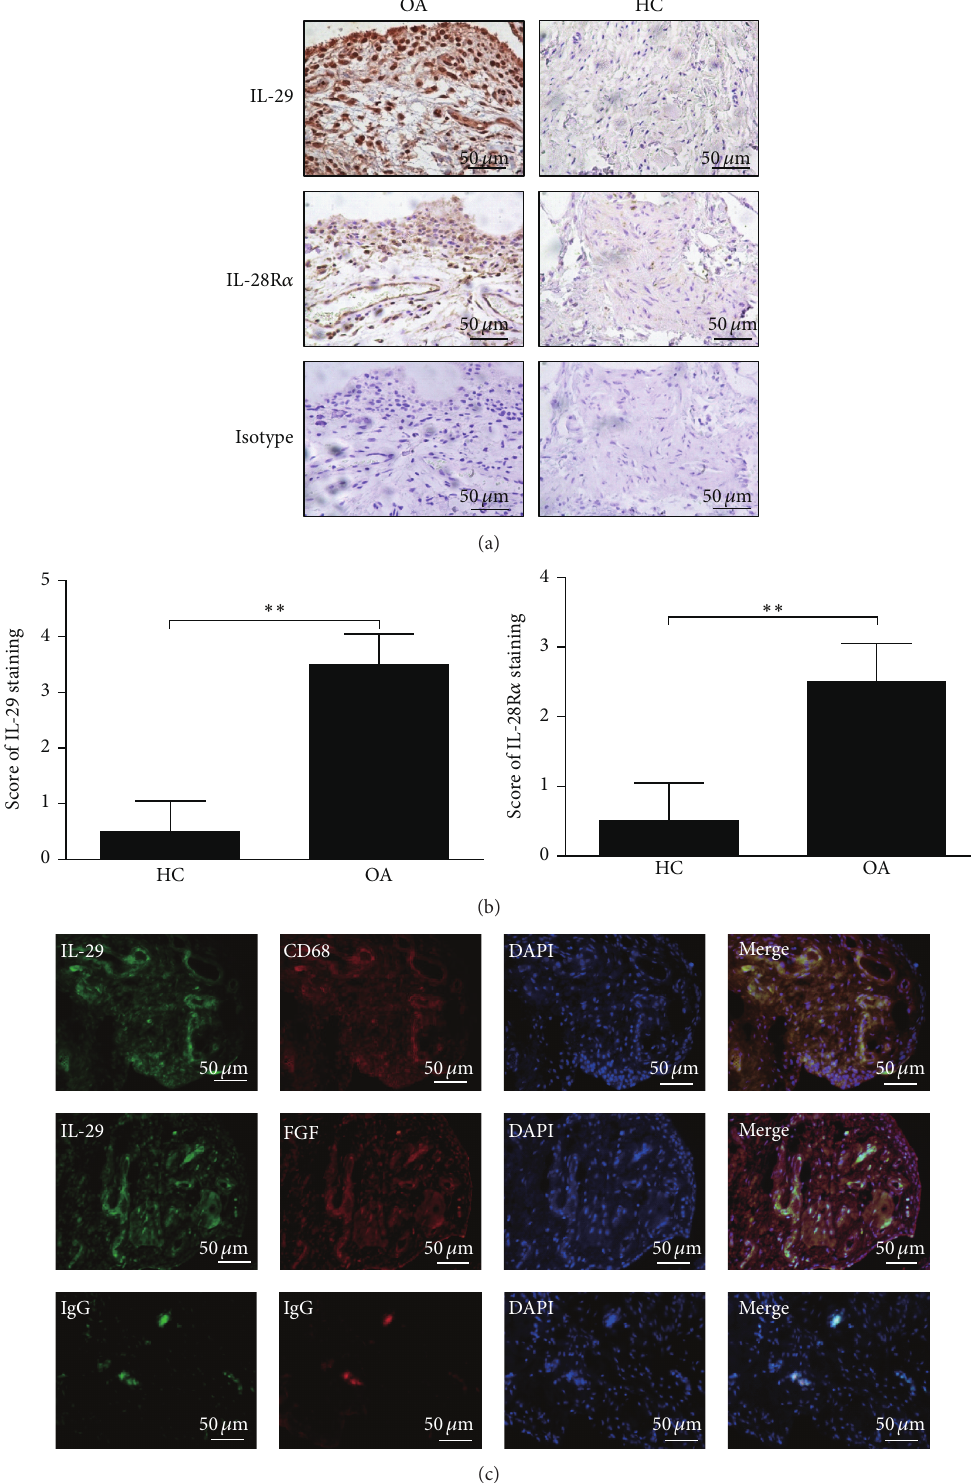
Figure 2: The expression and cellular distribution of IL-29 and IL-28R 𝛼 in the synovial tissues. IL-29 and IL-28R 𝛼 in synovial tissues of OA patients ( 𝑛 = 5 ) and HC ( 𝑛 = 3 ) were detected by immunostaining (a) and semiquantification (b). Values in (b) are the mean ± SEM. ∗∗ 𝑃 < 0.01 versus medium control. (c) Colocalization of IL-29 with CD68 or FGF-2 in OA synovium was detected by double immunofluorescence staining, and nuclei were counterstained with DAPI. All of the magnification in this figure was ×